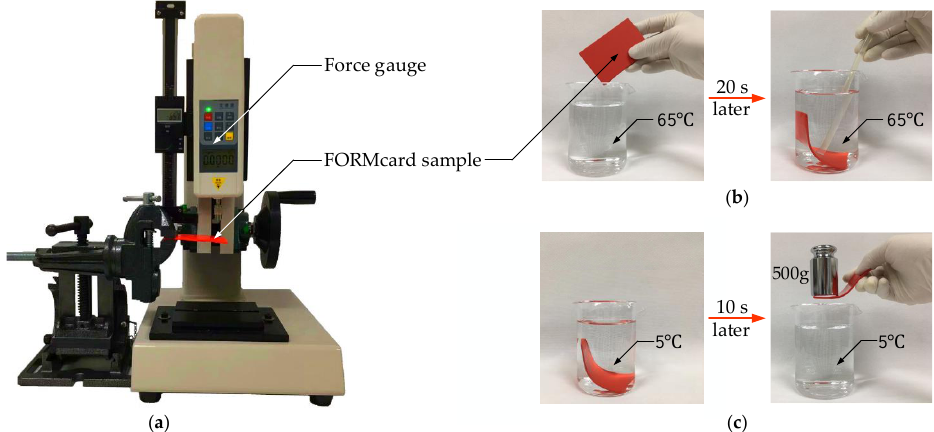
Figure 1. Preliminary property tests for FORMcard thermoplastic: ( a ) flexural modulus measurement using a commercial FORMcard product; ( b ) softening test after heating FORMcard thermoplastic sample with water at 65 ◦ C for 20 s; ( c ) stiffening test after cooling FORMcard thermoplastic sample with water at 5 ◦ C for 10